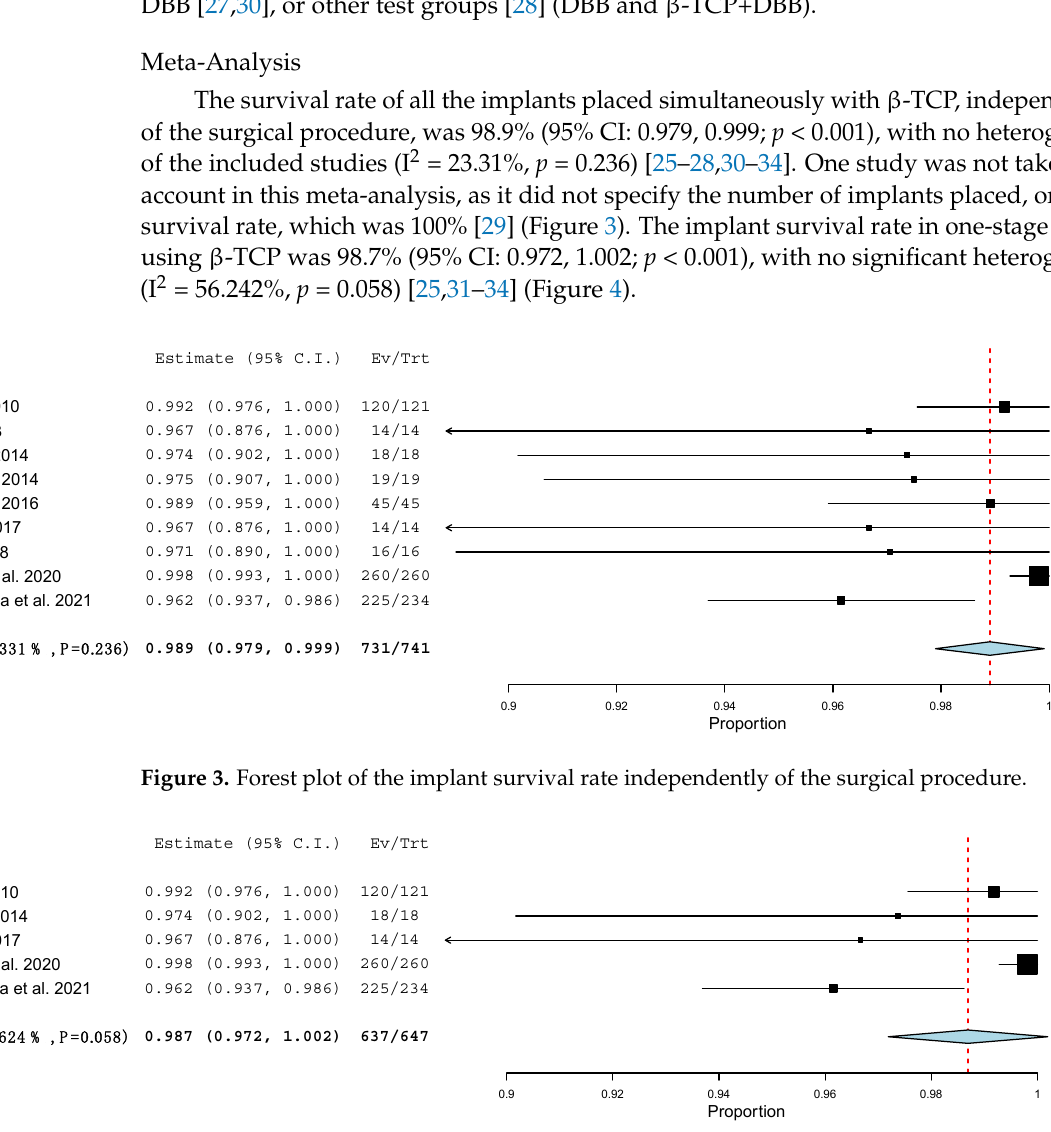
Figure 2. Risk of bias within the included RCTs.